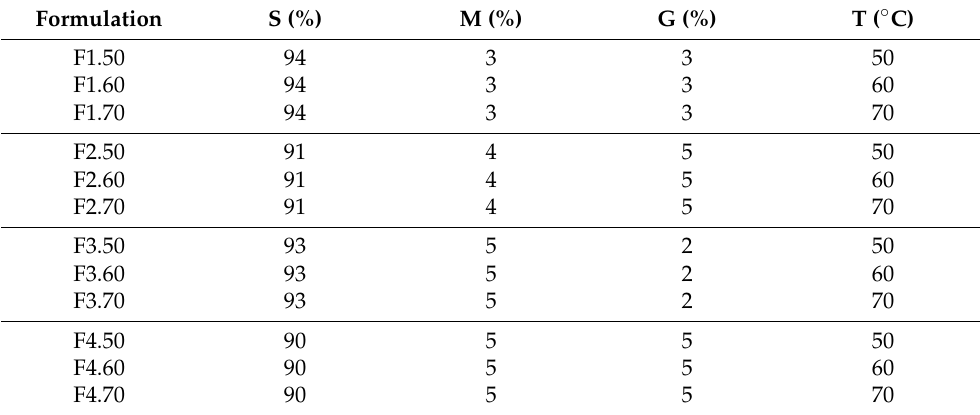
Table 1. Formulation of edible